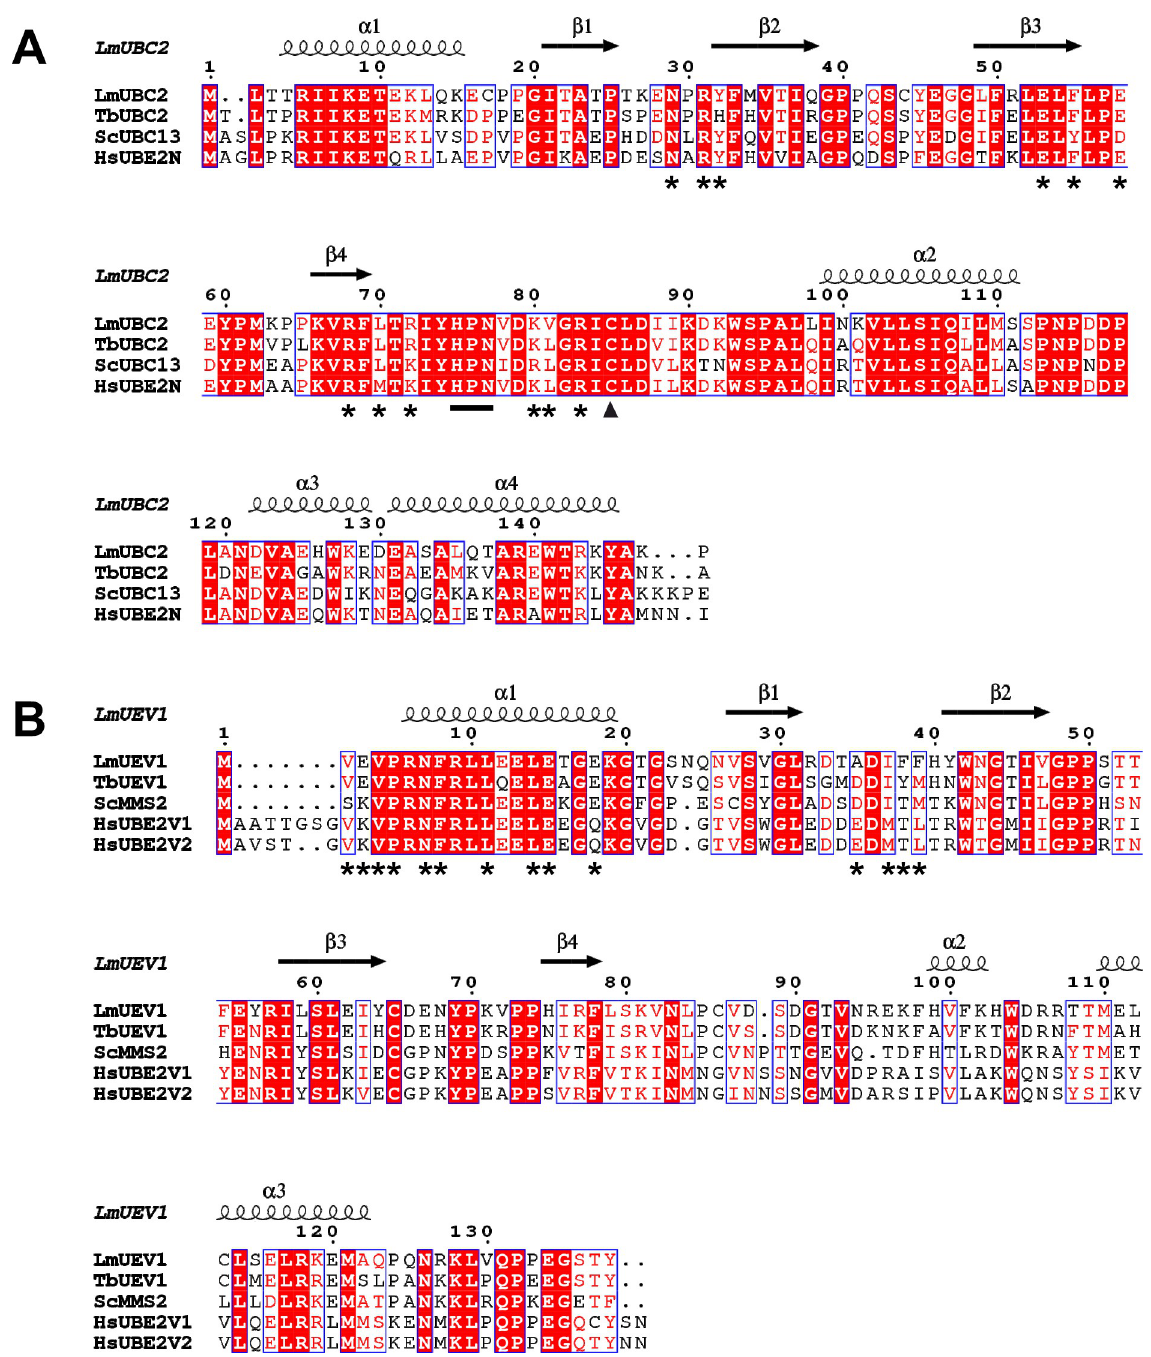
Fig 2. Alignments of LmUBC2 and LmUEV1 with selected orthologues. Sequence alignment and structural annotation were performed using T-Coffee and ESPript 3.0 respectively for A LmUBC2 and B LmUEV1. Red boxes indicate amino acid identity, red characters show similarity within the highlighted group and blue frames highlight similarity across groups. Positions of the UBC2 HPN motif and catalytic cysteine are shown by a black line and triangle respectively. Secondary structures derived from the crystallised L . mexicana UBC2-UEV1 heterodimer (Fig 4) are represented above the sequence alignment with helices represented by spirals and beta sheets by arrows. Asterisks denote important interface residues in the L . mexicana complex. Lm , Leishmania mexicana; Tb , Trypanosoma brucei; Sc , Saccharomyces cerevisiae; Hs , Homo sapiens